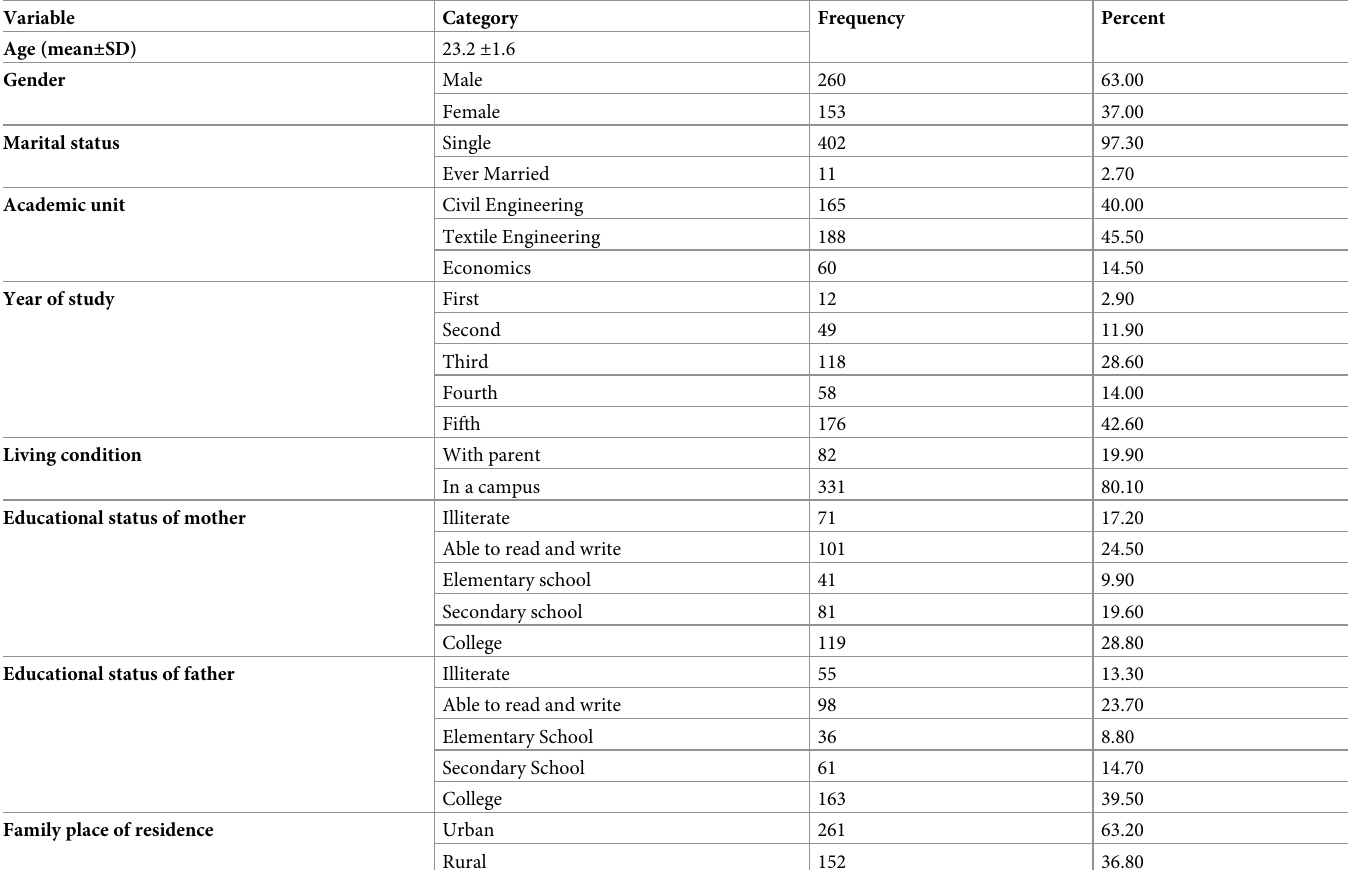
Table 1. Socio-demographic characteristics of respondents (n =